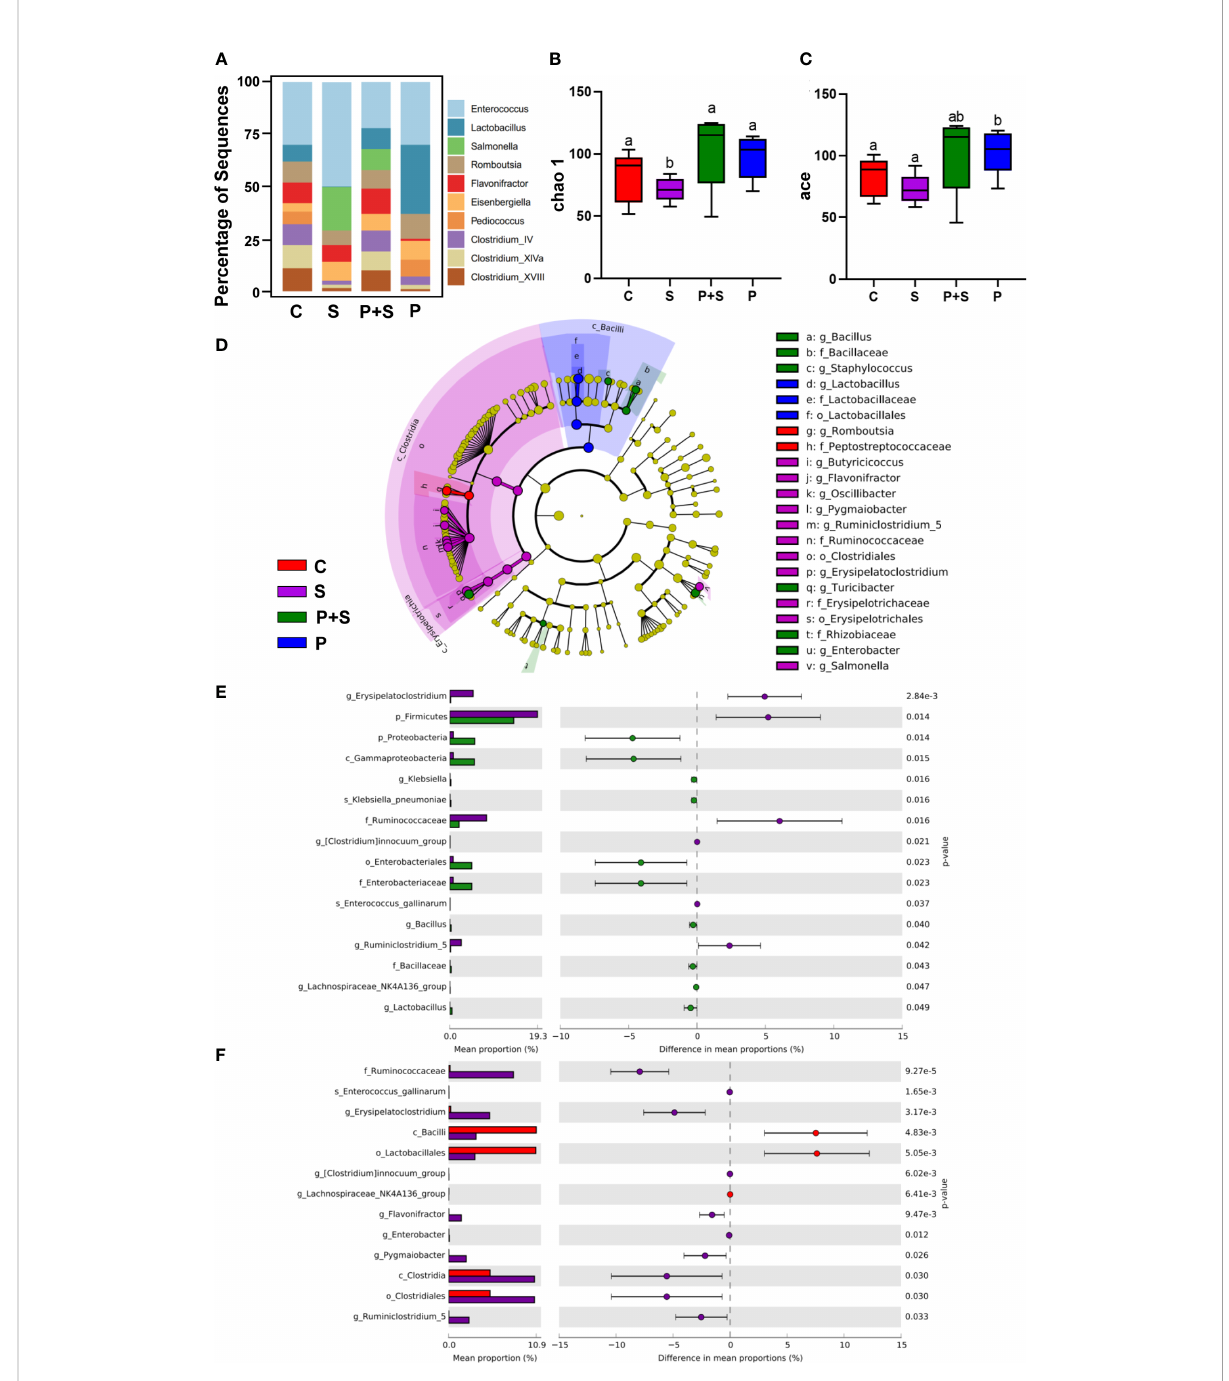
FIGURE 7 Full-length 16S rRNA sequence analysis of cecal contents in chicks and the micro fl ora data alpha- and beta-diversity analysis. (A) Comparison of the top ten distribution of bacterial communities in different treatment groups at the genus level. (B, C) Analysis of alpha diversity index of chicken intestinal fl ora under different treatment conditions. (D) Five-level cladogram of microbial communities in different treatment groups (threshold score > 2). The circle radiating from inside to outside represents the taxonomic level from phylum to genus (or species). Each small circle at different classi fi cation levels represents a classi fi cation at that level, and the diameter of the small circle is directly proportional to the relative abundance. The species with no signi fi cant difference are marked as yellow. The biomarker of the different species is the same as that of legend. (E) The top 16 differentially abundant bacteria at genus level in S vs P+S groups. If the former was not obtained, the classi fi cation at the genus level or the family/order level. Log scale was used in the abscissa. (F) The top 13 differentially abundant bacteria in S vs C groups at the genus level. If the former was not obtained, the classi fi cation at the genus level or the family/order level. Log scale was used in the abscissa. s_= species; g_ = genus; f_ = family; o_ = order; c_ = class; p_ = phylum. a, b, c, d: Means in a same item with different letters differ signi fi cantly ( P <